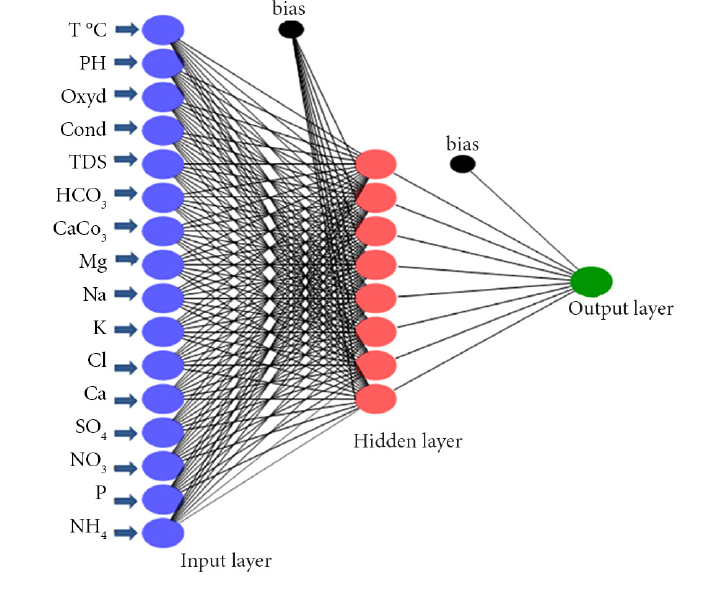
Figure 5. Architecture of the neural network with three configuration layers [16-8-1] used in this study